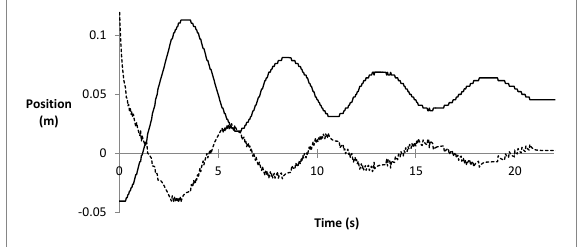
Figure 30: Step response for feedback‐linearized P‐D control Figure 29. Experimental step response for feedback-linearized PD